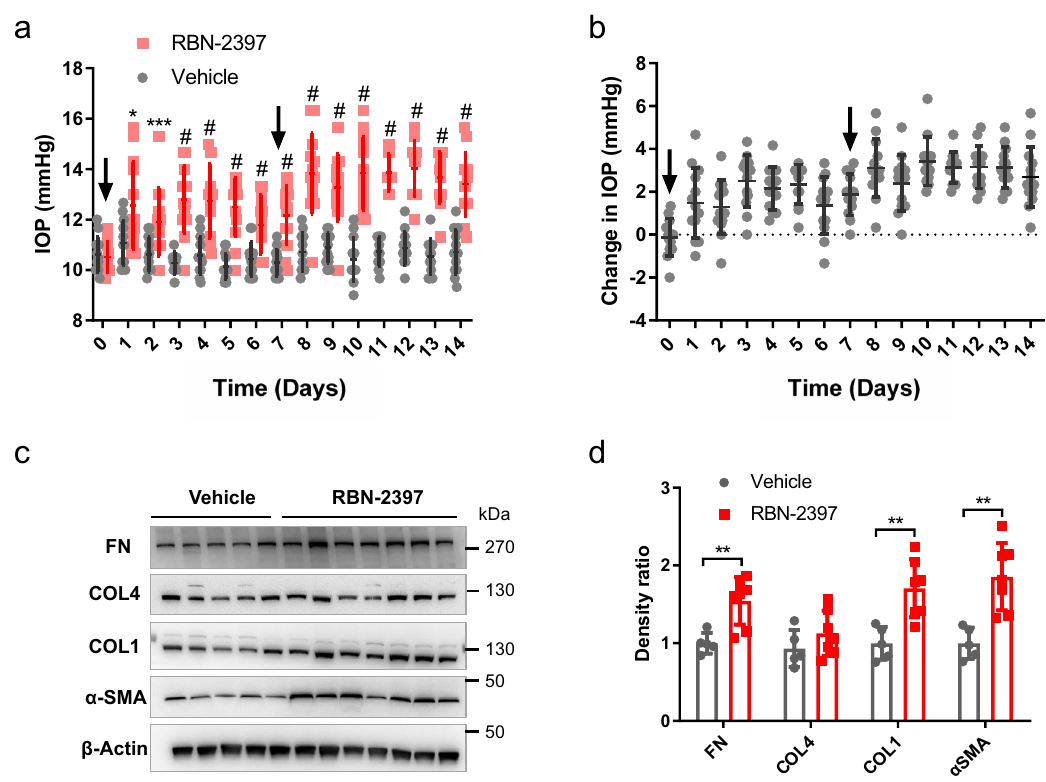
Fig. 7 Effects of the TIPARP inhibitor RBN-2397 on IOP in vivo. a A total 50 μ L of 10 μ M RBN-2397 was injected into the upper and lower subconjunctival space of Sprague – Dawley rat eyes on Day 0 and Day 7 (black arrows). IOPs were increased after RBN-2397 subconjunctival injection compared with that of the vehicle control group ( n = 13 eyes in each group). b Changes in IOPs due to RBN-2397 injection over time of the experiment compared to those of the vehicle control group are shown. c , d Western blot and quantitative analyses showed that the expression of fi bronectin, collagen type I and α -SMA increased in out fl ow tissue after RBN-2397 injection ( n = 7 in the RBN-2397 group and n = 5 in the vehicle control group). Data are presented as the means ± standard deviations. * P < 0.05, ** P < 0.01, *** P < 0.001, # P < 0.0001. COL1 collagen type I, COL4 collagen type IV, FN fi